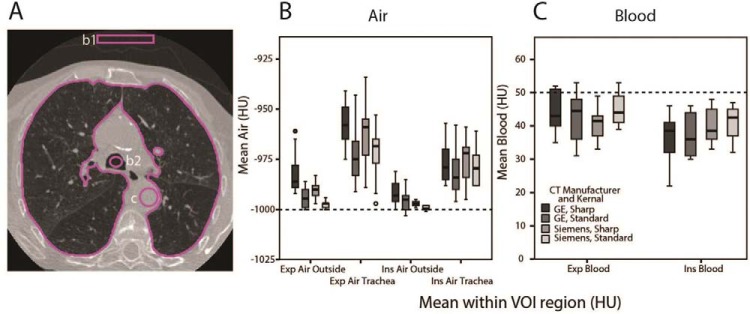
Impact of CT vendor and reconstruction kernel. HU values are measured in ambient air (b1), tracheal air (b2), and aortic blood (c) for 2 scanner brands and standard and sharp reconstructions. The 3 regions of interest are depicted in a representative axial CT slice (A). Box plots are presented for the HU values of air (B) and aortic blood (C) obtained from CT data acquired from different CT vendors and reconstruction kernels. For reference, ideal air and water attenuation values should be −1000 HUs and 0 HUs, respectively, with a target blood value of 50 HUs (27). The lines on the box plot are as follows: center line, median; bottom and top boxes, 25% and 75% quantiles, respectively; bottom and top bars, 1.5 times the box size or the minimum value if no values fall in that range. Note for normally distributed data approximately 95% of the data are expected to lie between the distal fences.